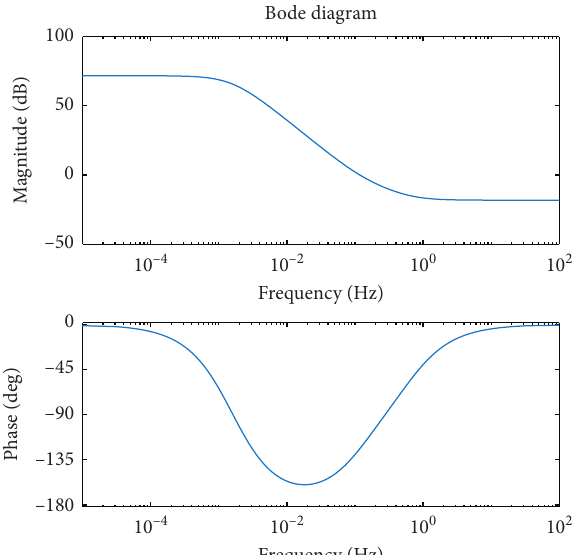
Figure 5: Bode diagram of the weighting function W